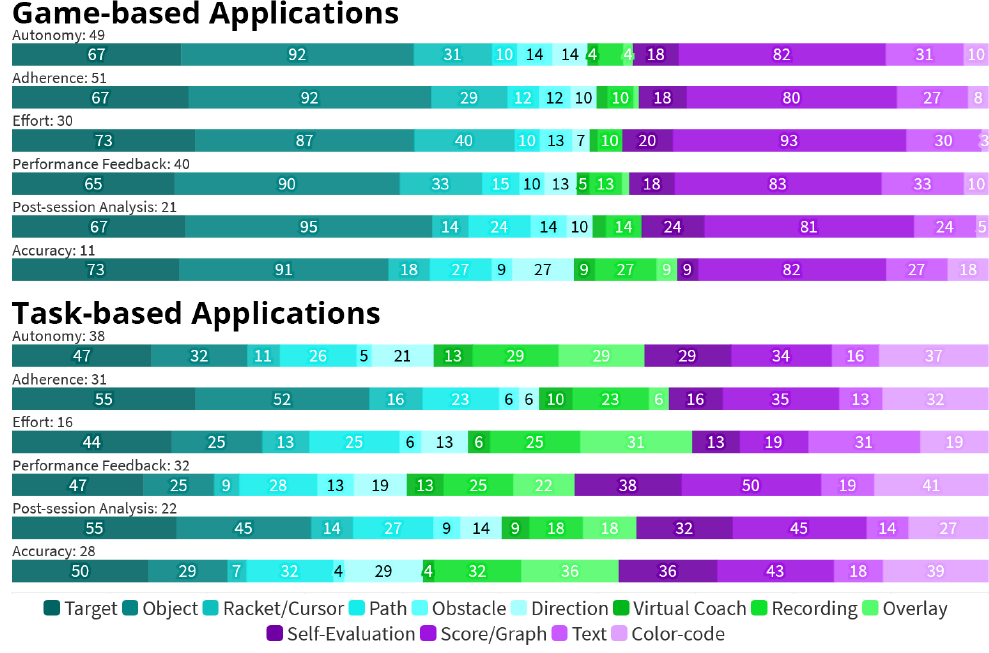
Figure 8. Usage of Visual Guidance elements by Application Type and targeted Advantage . Numbers on the bars represent the percentage of applications utilizing a Visual Guidance element. The bar’s width represents the relative frequency within the respective Added Value